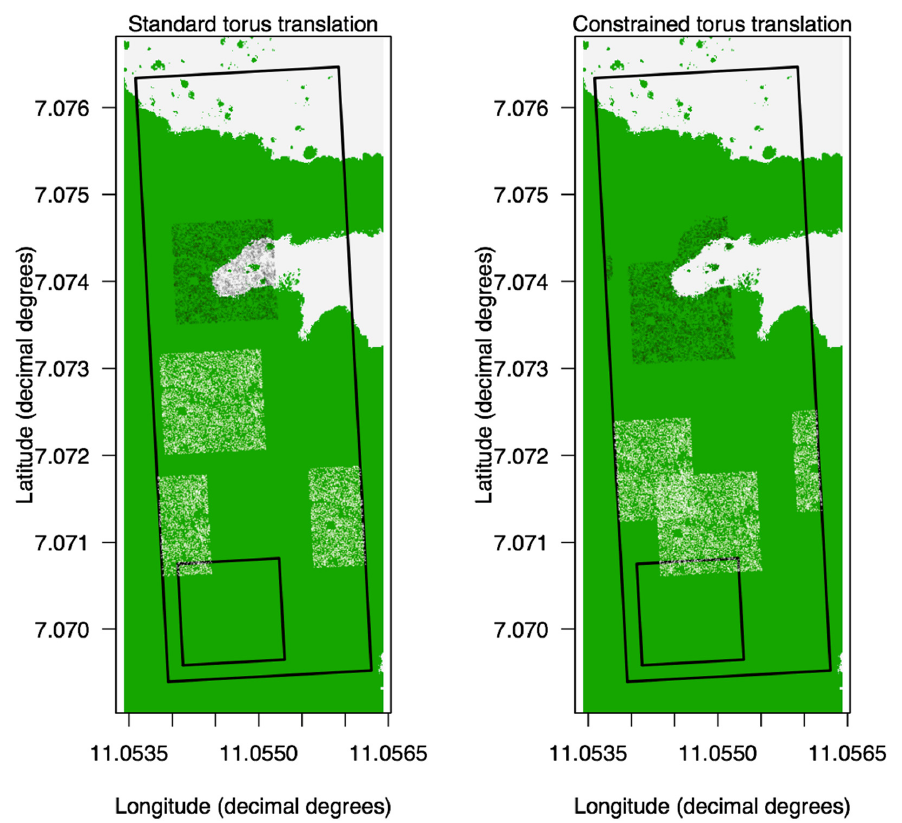
Figure 3. Comparison between the standard (unconstrained) torus translation ( A ) and the constrained version that we used in our study ( B ). The square polygon within the plot corresponds to the original position of a subset of stems, used as an example. Three random translations of this subset of stems are presented for comparison purposes. When the stems land within forest after the translation, both methods behave similarly (whitish points). When the stems land within grass, the constrained translation makes them “jump” again until they find forest, distorting to some degree the translated cloud of points (black points). The standard (unconstrained) translation does nothing in particular, since it is blind to the forest vs. grass distinction. This non-adaptive behavior of the standard torus translation contributes to the unrealistic null expectation of “many stems within the grass”, that we wanted to